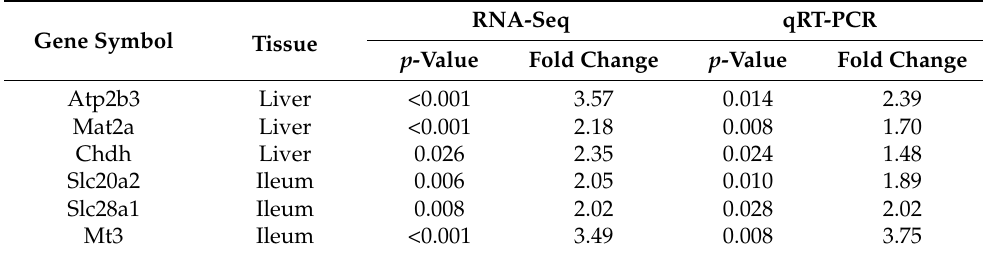
Table 3. Results of quantitative qRT-PCR validation.